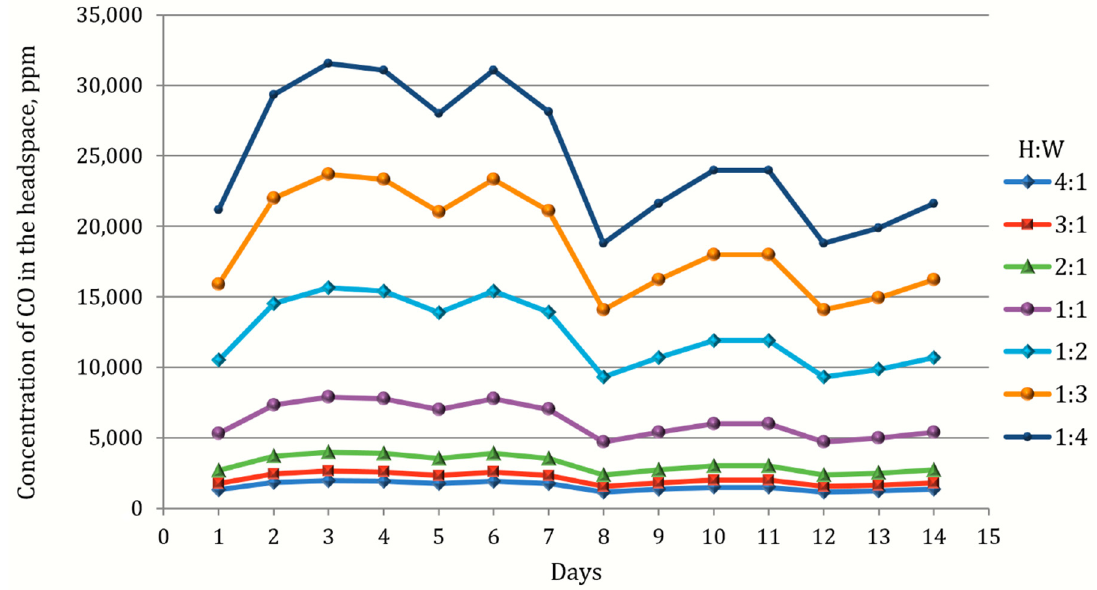
Figure 5. CO concentration in the daily release of gas accumulated in the bioreactor headspace.